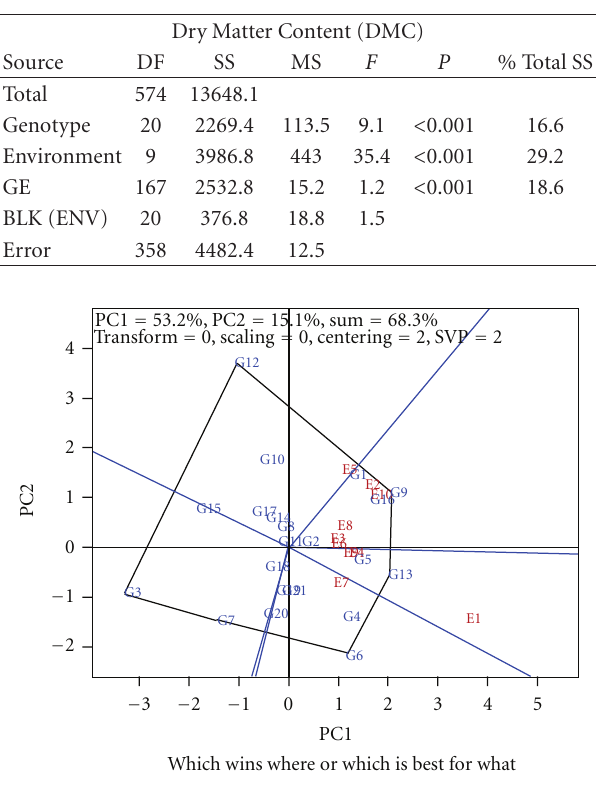
Figure 3: Megaenvironments defined by di ff erent winning yellow- fleshed cassava genotypes tested in 10 environments for the average root DMC